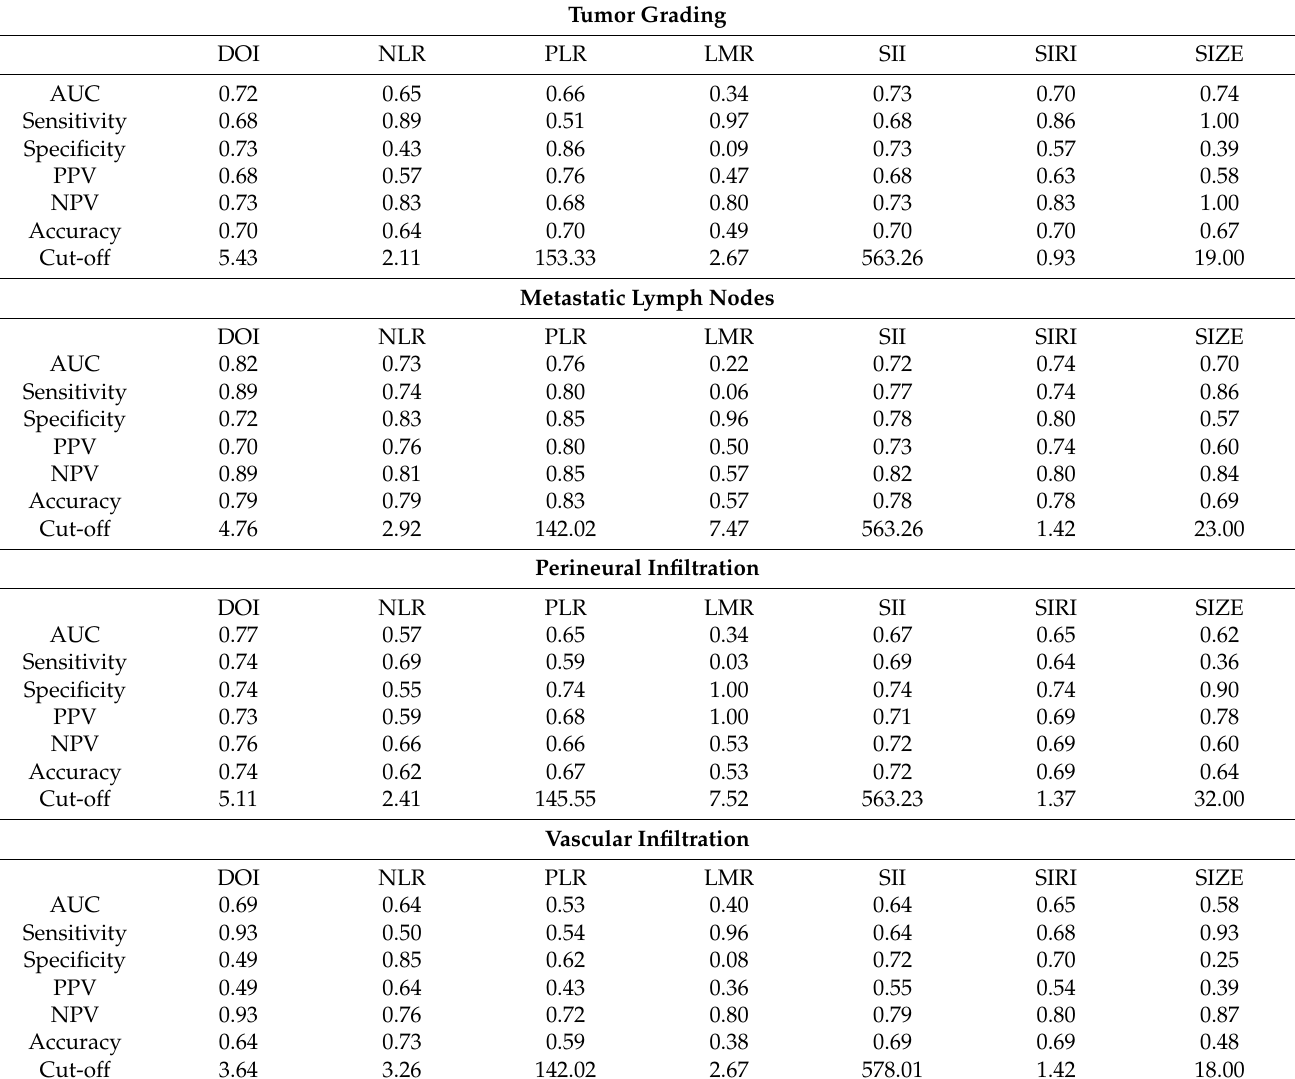
Table 1. Univariate analysis. Results of the ROC analysis of the following clinical parameters: depth of invasion (DOI), neutrophils − lymphocytes ratio (NLR), platelet − lymphocyte ratio (PLR),